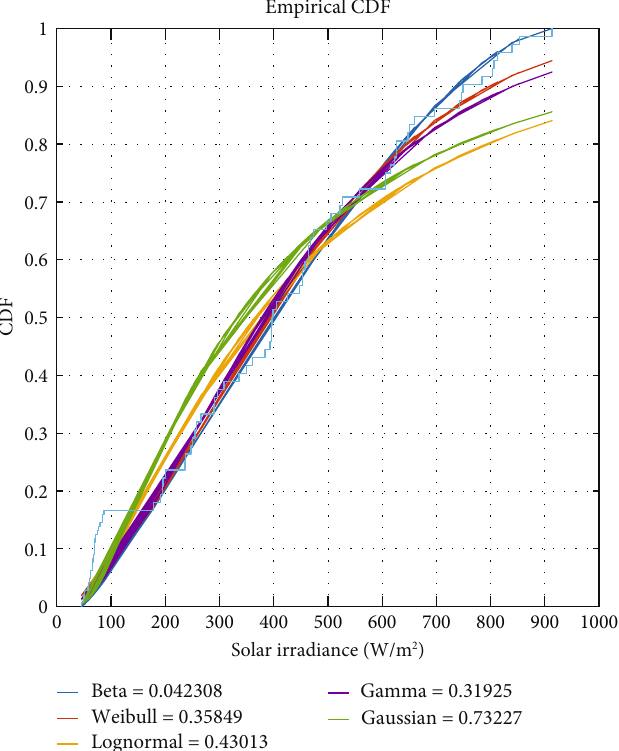
Figure 14: Comparison of simulated and actual